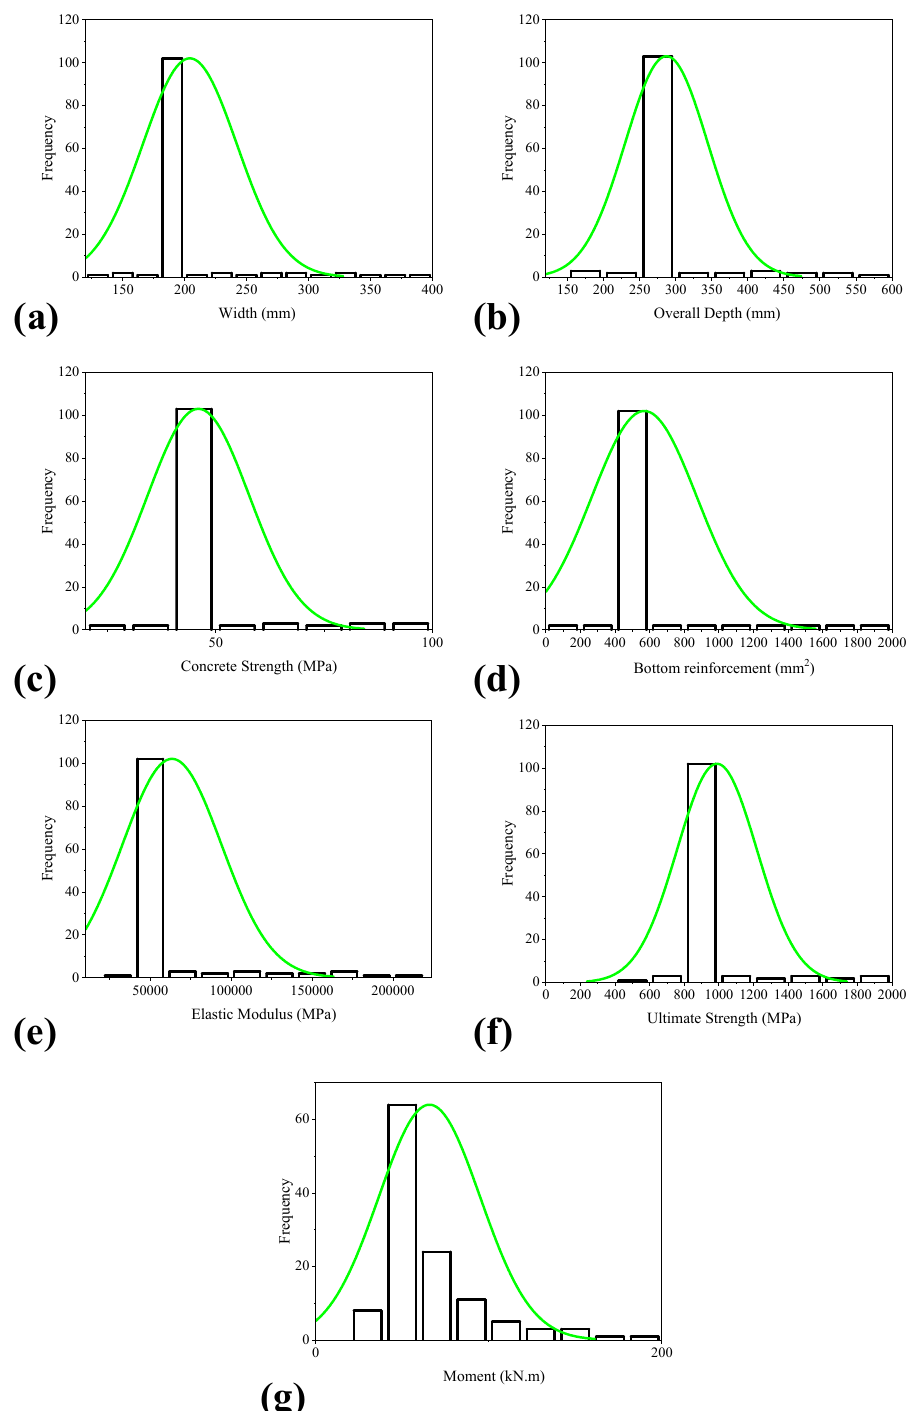
Figure 1. Histograms of the input and output parameters used in the current study; ( a ) Width, ( b ) Overall depth, ( c ) Concrete strength, ( d ) Bottom reinforcement, ( e ) Elastic modulus, ( f ) Ultimate strength, and ( g ) Moment.